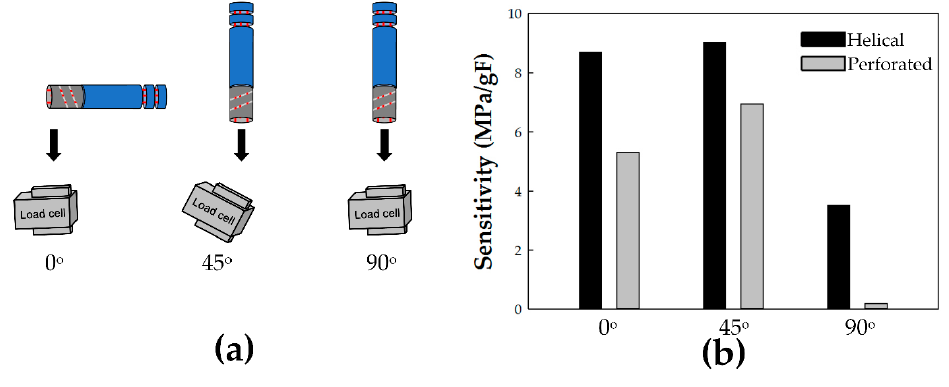
Figure 2. ( a ) Axial and lateral force at three degree conditions ( b ) sensitivity of helical and perforated pattern structure at three degree